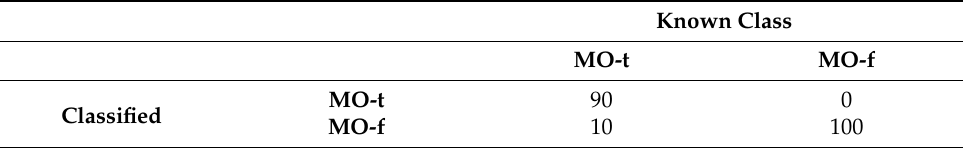
Table 4. Confusion matrix for musky octopuses: MO-t (thawed); MO-f (fresh). Performance: F 1 = 0.939. All values are expressed in